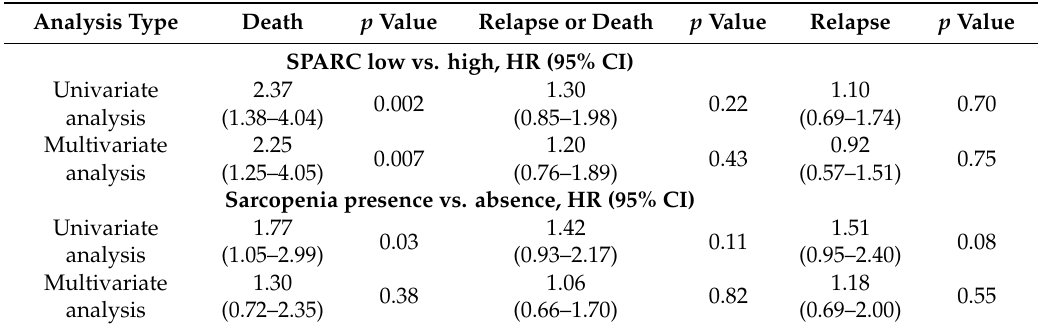
Table 2. Univariate and multivariate analyses of serum SPARC levels or sarcopenia for